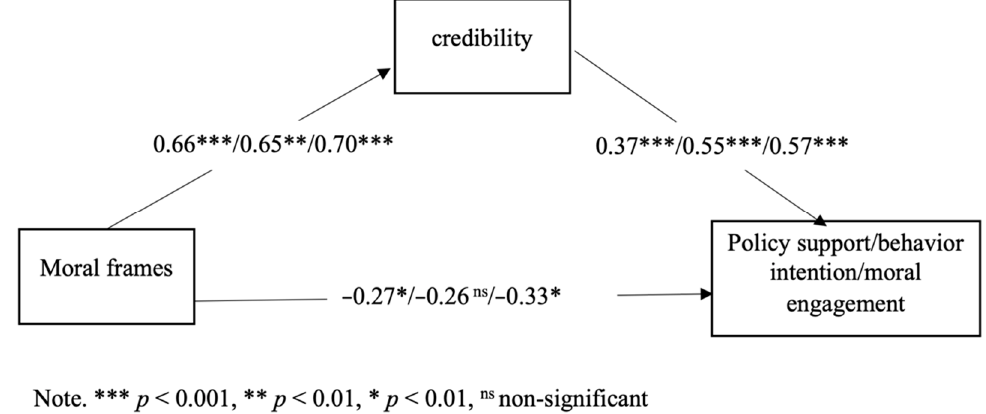
Figure 4. Mediation only model with standardized coefficients in the main study.